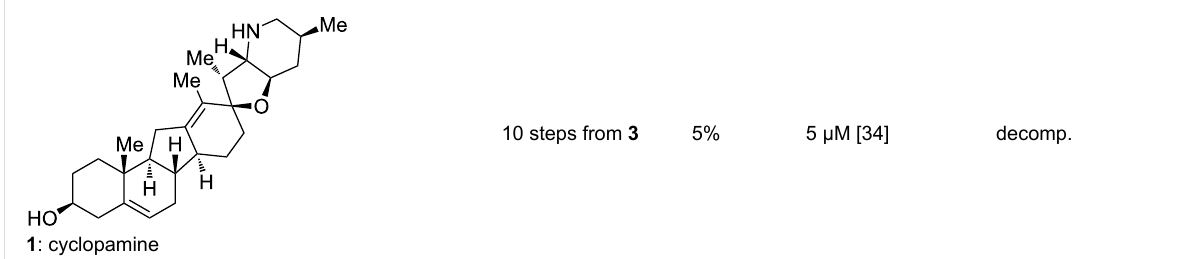
10 steps from 3 5% 5 µM [34]